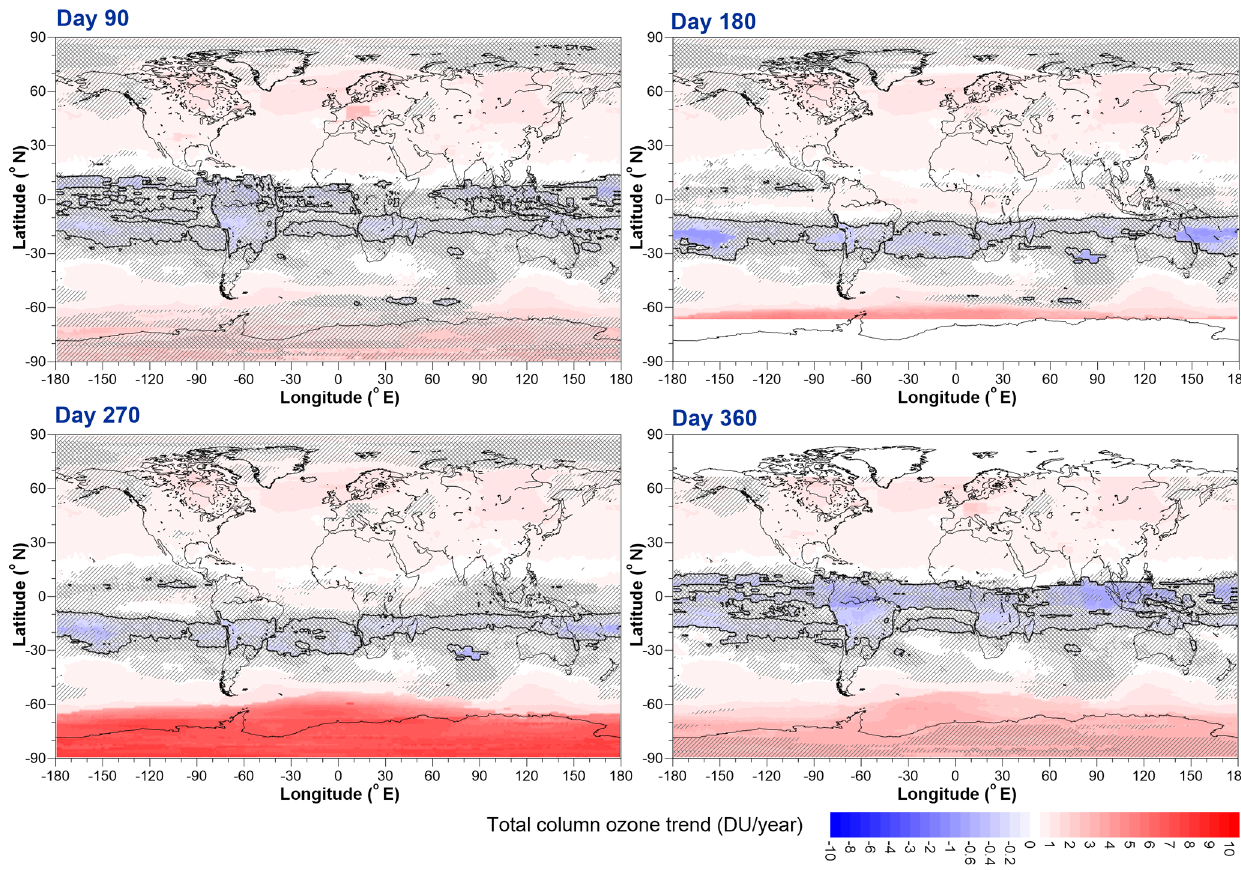
Figure 17. The change in TCO trends after 2000 evaluated at (a) day 90, (b) day 180, (c) day 270, and (d) day 360. The solid black line shows zero trend. The same hatching regimen as used in Fig. 16 is used